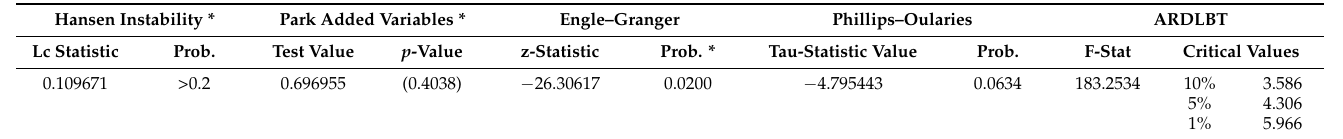
Table 3. Cointegration tests’ results.